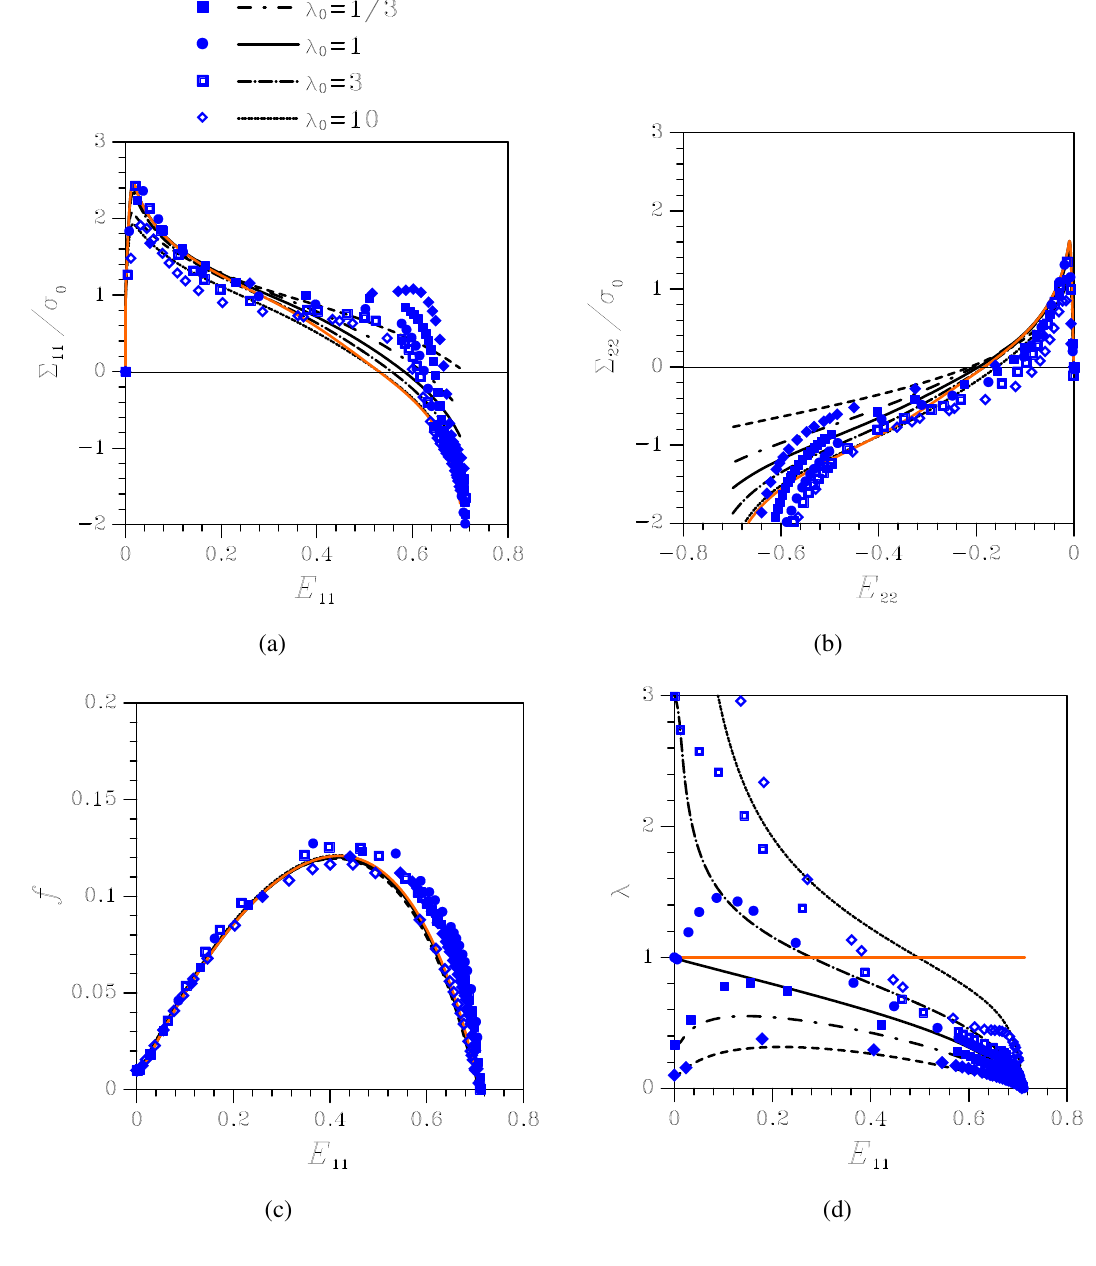
Figure 5 . Effect of the initial aspect ratio λ on the nonlinear response of the orthotropic 0 porous-plastic solid at k = − 0 . 5 . Comparison among the proposed constitutive model ε (black lines), the Gurson’s model (orange line), and unit-cell simulations (blue symbols) in terms of: (a) Cauchy stress Σ vs logarithmic strain E ; (b) Cauchy stress Σ 11 11 22